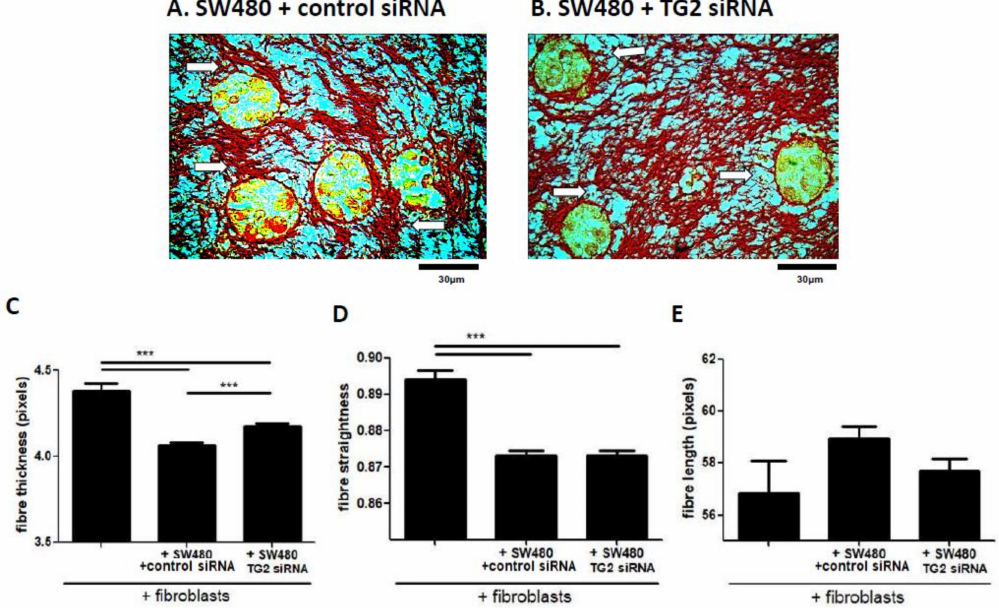
Figure 5. SW480-derived TG2 drives fibroblast-mediated structural alterations in co-cultures. Sirius red staining of fibroblast / SW480 co-cultures showed regions of dense collagen at the CRC / stroma boundary with untreated SW480 cells ( A , white arrows) and thinning regions at this boundary once SW480 cells were treated with TG2 siRNA ( B , white arrows). Collagen fibre thickness was significantly lower once SW480 cells were introduced into cultures, compared to gels cast with fibroblasts alone ( C , n = 27). When treated with TG2 siRNA, the reduced fibre thickness induced by SW480 cells was partially reversed ( C , n = 27). SW480 cells also resulted in less straight fibres compared to gels cast with fibroblasts alone ( D , n = 27), but TG2 siRNA treatment of the SW480 cells had no e ff ect. Significant di ff erences in fibre length were not observed between gels cast with fibroblasts alone, SW480 cells, or with SW480 cells treated with TG2 siRNA ( E , n = 27). *** p <